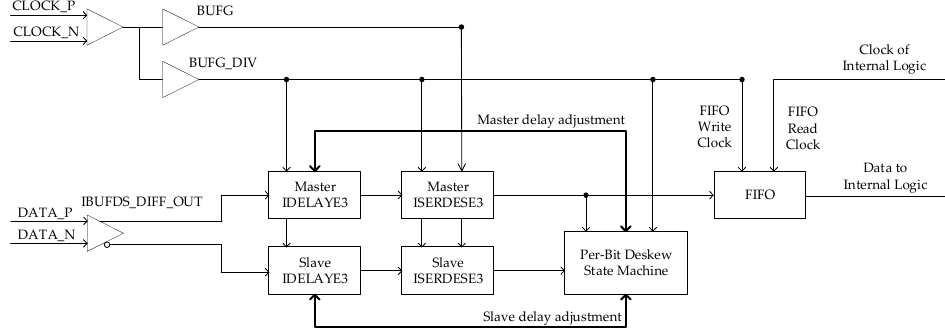
Figure 8. Schematic of the data reception module.